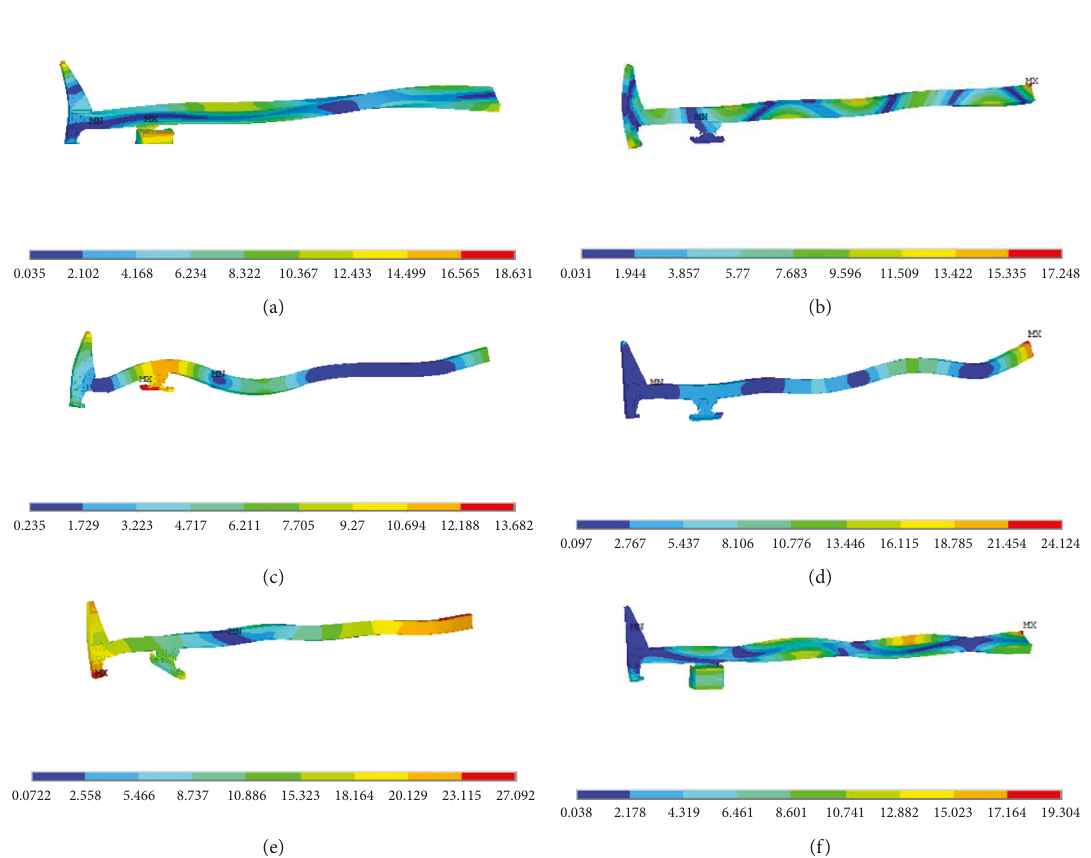
Figure 5: Vibration modes of coke pusher. (a) 13th mode shape; (b) 14th mode shape; (c) 16th mode shape; (d) 19th mode shape; (e) 20th mode shape; (f) 24th mode